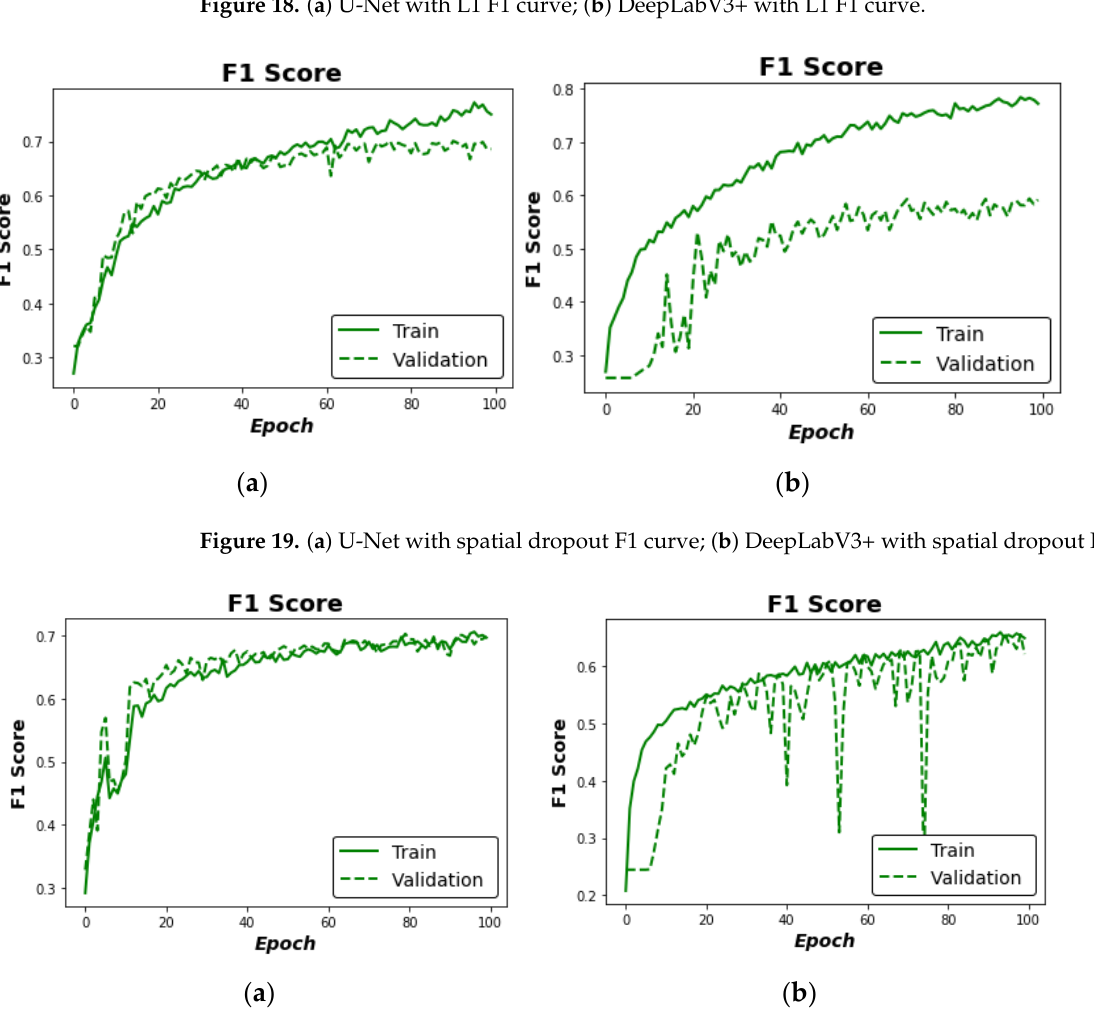
Figure 20. ( a ) U-Net with L1 and spatial dropout F1 curve; ( b ) DeepLabV3+ with L1 and spatial dropout F1 curve.